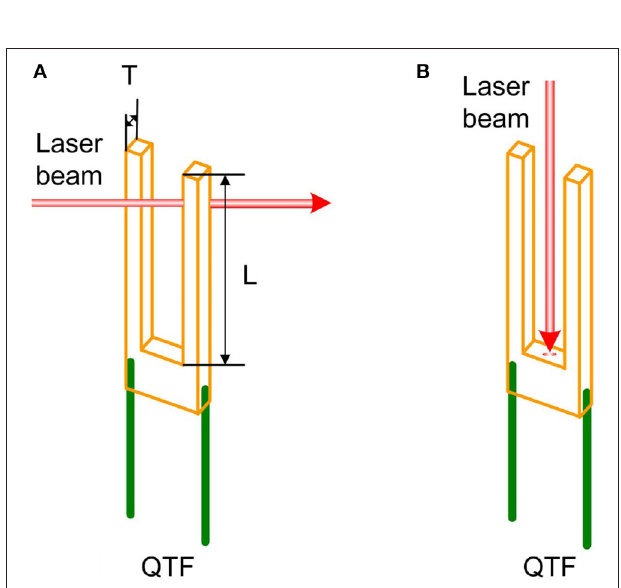
FIGURE 6 | The relationship between laser beam and QTF plane. (A) Perpendicular plane (PP-QEPAS). (B) In plane (IP-QEPAS). Reproduced from [90], with the permission of AIP